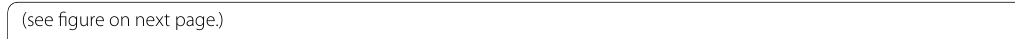
Fig. 1 Structures of various alkaloids of genus Fritillaria : 1. solanidine, 2. kuroyurinidine, 3. impericine, 4. forticine, 5. delavine, 6. persicanidine A, 7. imperialine, 8. dihydroimpranine, 9. impranine, 10. fetisinine, 11. korsevine, 12. verticinone, 13. verticine, 14. ebeiedine, 15. ebeiedinone, 16. chuanbeinone, 17. sinpeinine A, 18. imperialine-3-β-glucoside, 19. dongbeinine, 20. dongbeirine, 21. zhebeinine, 22. peimine, 23. isoverticine, 24. zhebeinone, 25. eduardinine, 26. eduardine, 27. zhebeirine, 28. 3β-hydroxy-5α-jervanin-12-en-6-one, 29. frithunbol A, 30. frithunbol B, 31. yibeinine, 32. yubeinine, 33. hupehenine, 34. yibeinoside, 35. imperialine-3β-D-glucoside, 36. (20R,22R,23R,25R)- 3b,23-dihydroxy-N-methyl-veratram-13(17)- en-6-one 37. sipeimine, 38. ebeiensine, 39–42. yibeinones A-D, 43. peimisine, 44. imperialine-β-N-oxide, 45. isoverticine-β-N-oxide, 46. yibeissine, 47. yibeinoside B, 48. ebeinine, 49. ebeienine, 50. 22S,25S,5α-Vertram ine—7(8),12(14)- diene-3β,13β,23β-triol-6-one, 51. 3β,23β-dihydroxy-7,12(14)- dien-5α-veratramin-6-one, 52. (3β,5α,13α,23β)-